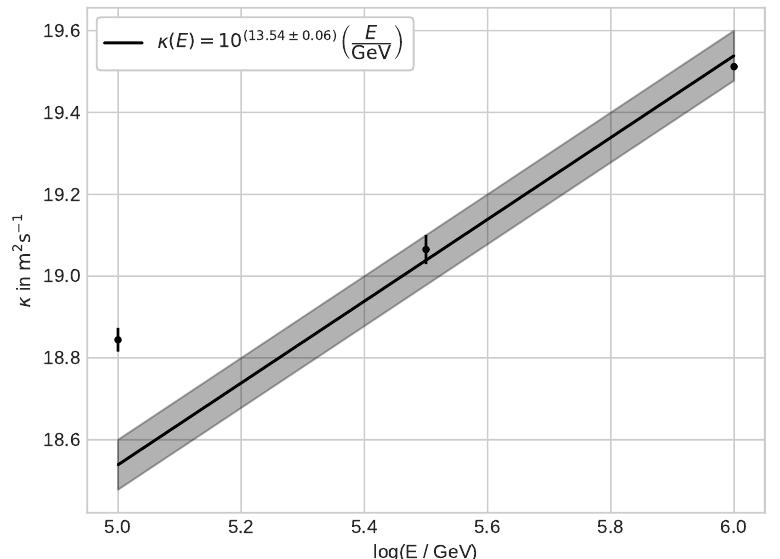
Figure 6. Steady-state diffusion coefficient as a function of energy for particles between 10 5 GeV and 10 6 GeV. A linear regression for the function κ ( E ) = κ 0 · ( E /GeV ) is performed, with the uncertainty band depicted as gray shaded area. Here, κ 0 is the normalisation constant. The linear behavior with energy is based on the assumption that Bohm diffusion is dominant in the purely turbulent